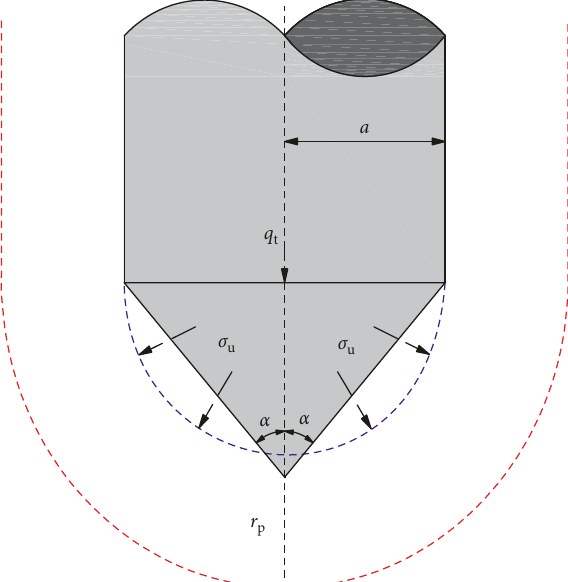
Figure 4: Assumed analysis model for piezocone penetration.